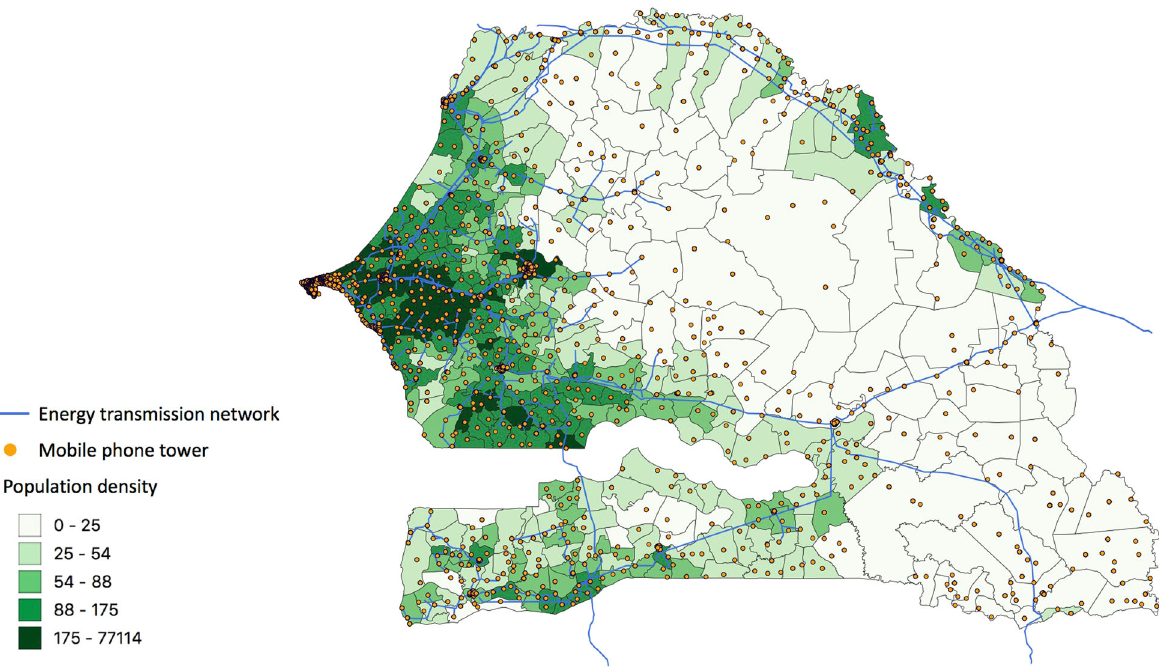
Fig. 1 Energy transmission network, mobile phone coverage, and population density. Senegalese municipalities are coloured by population density. Solid blue line indicates the energy transmission network. Orange dots mark mobile phone towers.